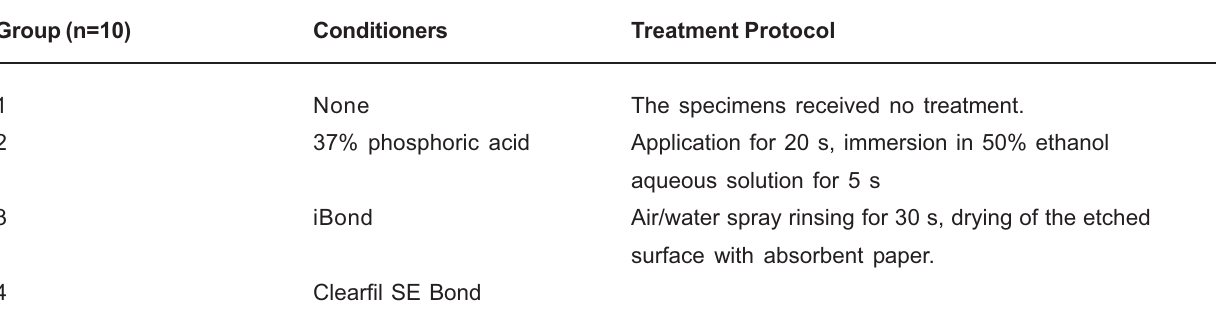
FIGURE 1- Conditioners, manufacturers and respective chemical compositions Conditioners 37% phosphoric acid gel iBond all-in-one self-etching adhesive system Clearfil SE Bond self-etching adhesive system with